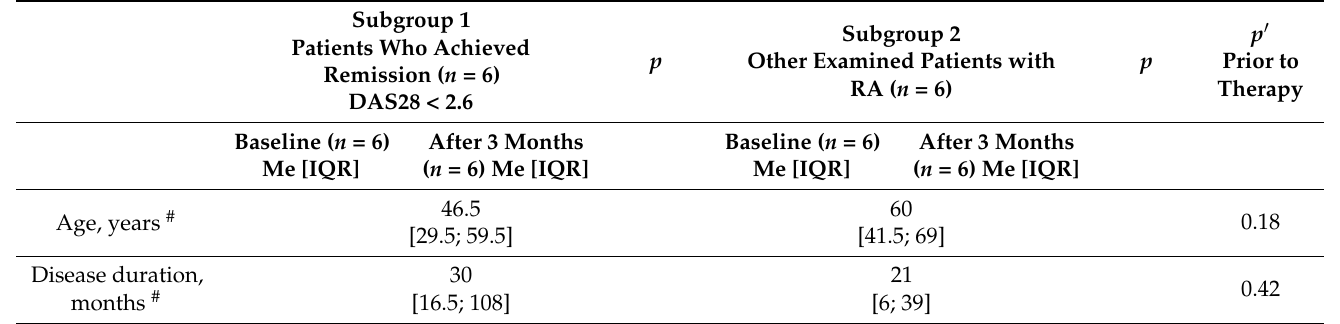
Table 1. Characteristics of patients who achieved remission ( n = 6) and other examined patients with rheumatoid arthritis ( n = 6) prior to and after tofacitinib